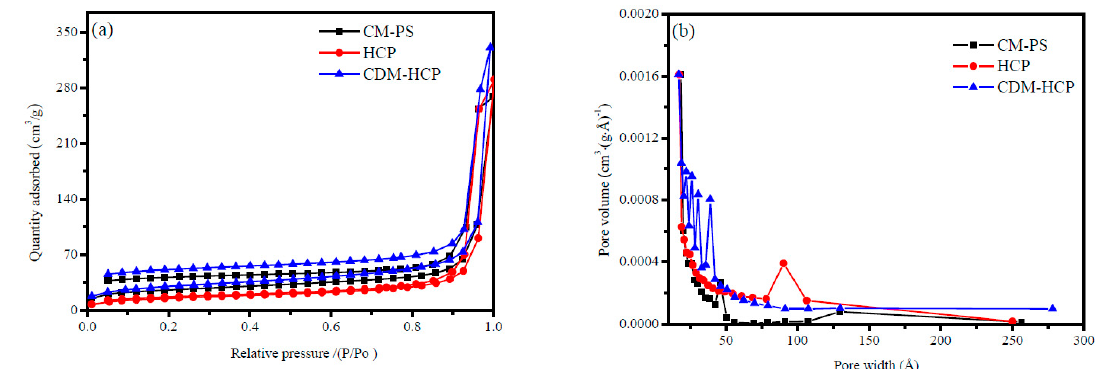
Figure 4. Adsorption–desorption isotherms ( a ) of N 2 at 77 K and pore-size distribution ( b ) of CM-PS, HCP, and